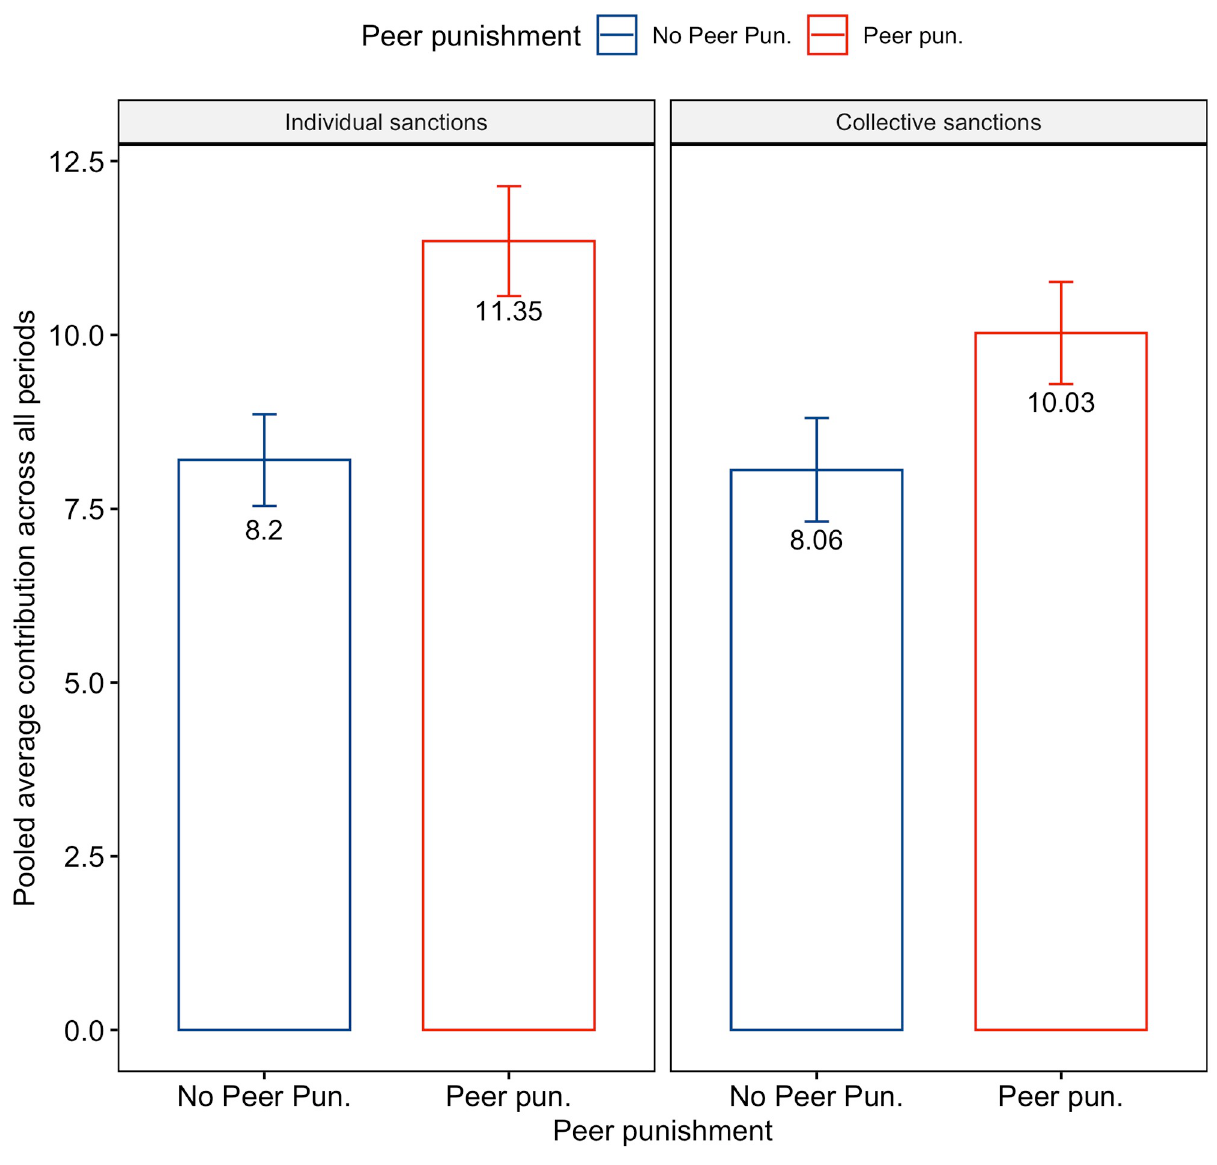
Fig 1. Average contributions per